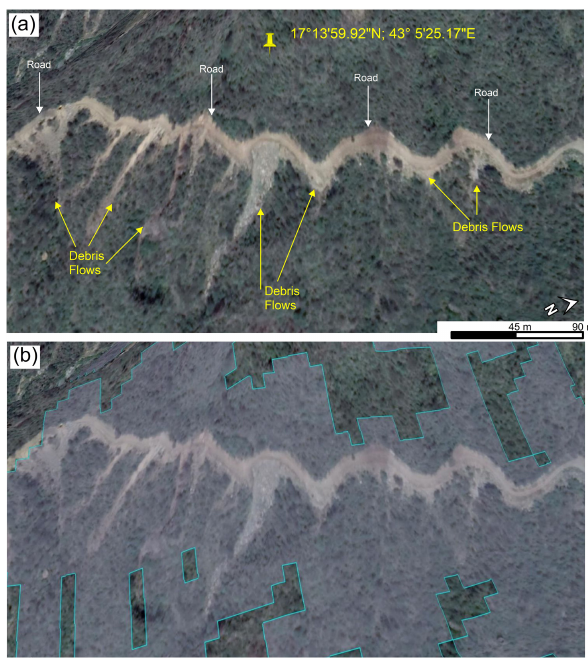
Figure 6. Google Earth imagery (map data: Google, DigitalGlobe, and CNES/Airbus) showing the spatial refinement procedures. (a) Areas showing debris flows within areas characterized by steep slopes ( > 30 ◦ ) and proximity to roads ( < 100m) and to the first- order streams ( < 20m). (b) The areas that satisfy these three condi- tions are outlined by the shaded polygon.